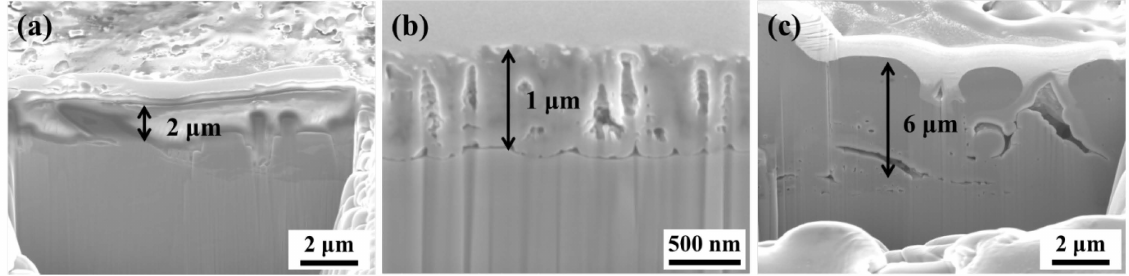
Figure 2. Focused ion beam (FIB) images of surface-modified Ti: ( a ) HA, ( b ) SLA/AO, and ( c )